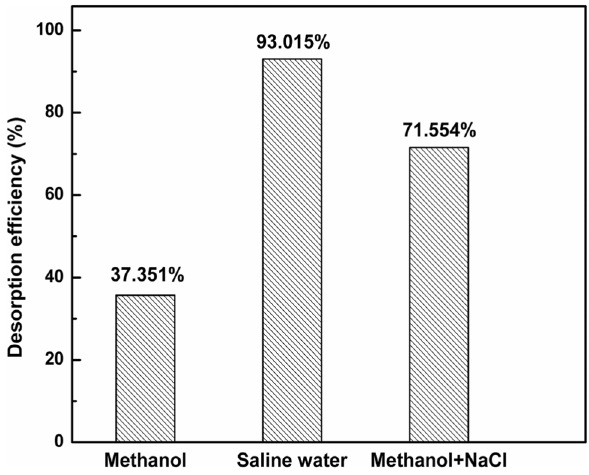
Fig. 9 Desorption efficiency for different eluents for 100 mg/L MB solutions onto 0.2 g of BNH-CM for 6 h at 30